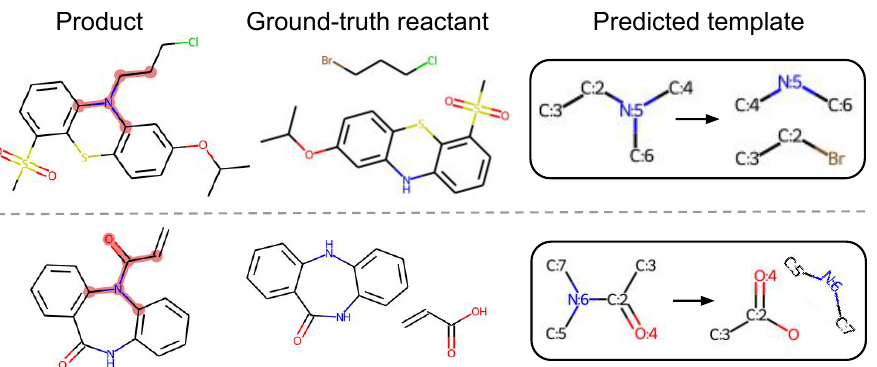
Figure 4. Our method successfully finds valid templates for two test reactions that are not covered by training data. The matched product subgraphs are highlighted in pink for better